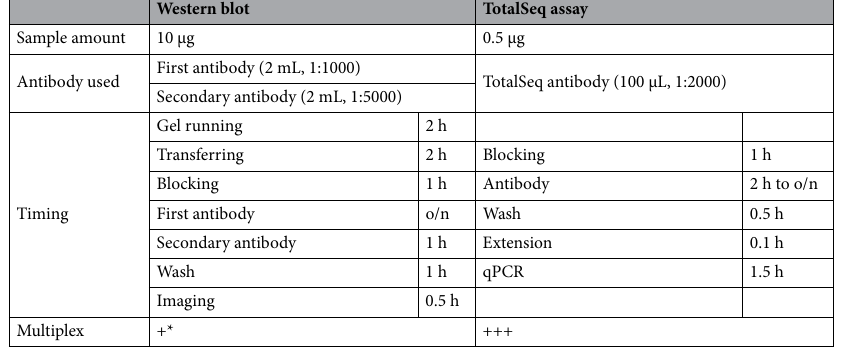
Table 1. Comparison of Western blot and TotalSeq assay. *When using fluorescent secondary antibody or stripping